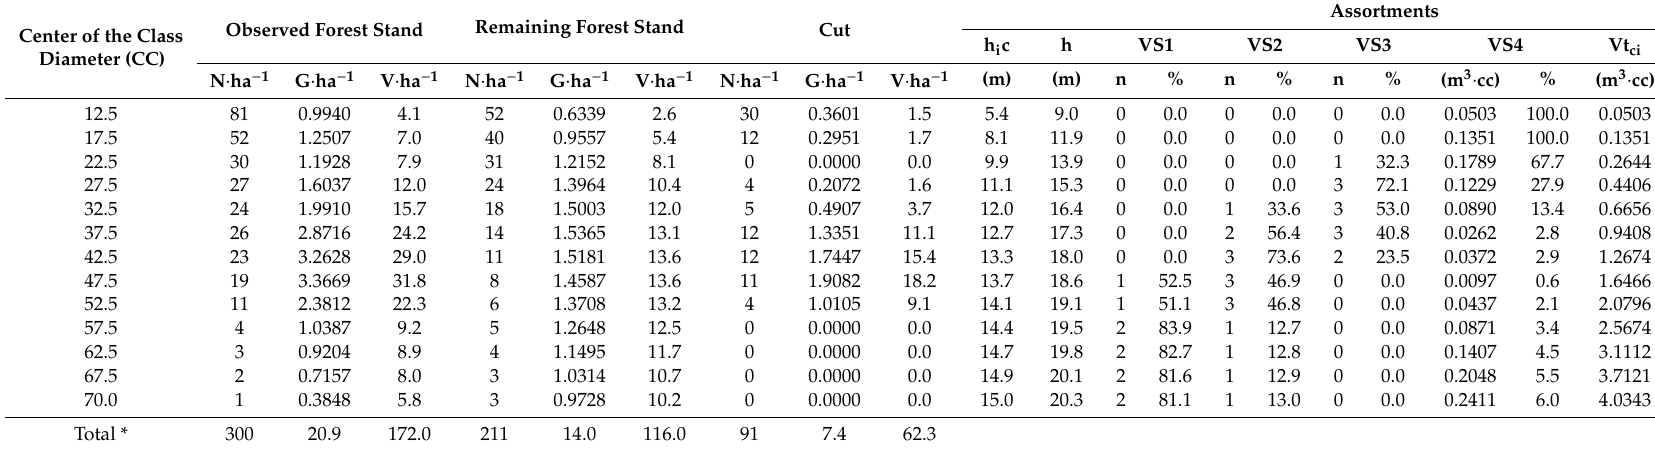
Table 2. Simulation of activities in the observed / remaining stand, and of the cuts to be performed according to the wood assortment classification, with